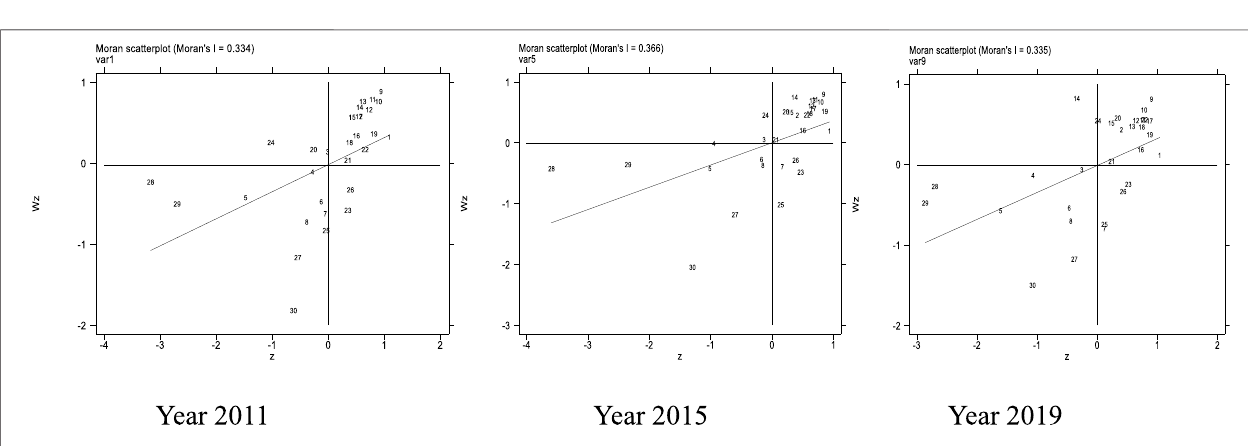
FIGURE 3 | Scatter plot of the Moran ’ s I of China ’ s environmental regulation in 2011, 2015, and 2019.